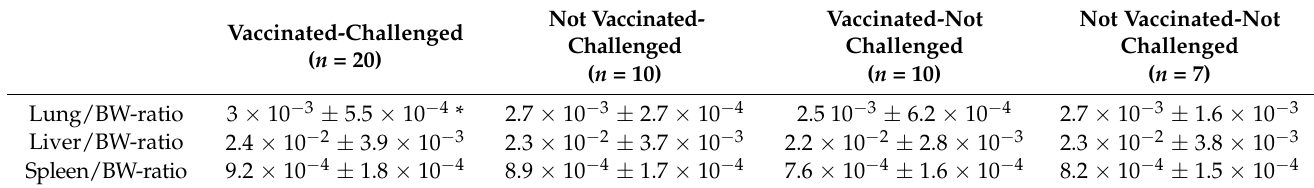
Table A1. Organ/BW-ratio.